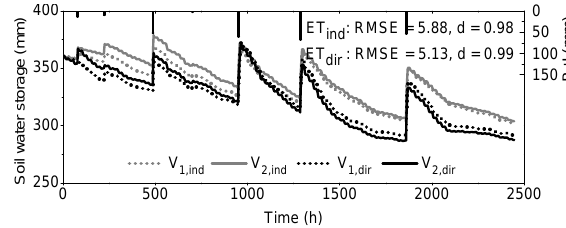
Figure 4. Comparison between simulated root-zone water storage using different methods (i.e., V 1 , ind , V 2 , ind , V 1 , dir , V 2 , dir ) , with measured precipitation and irrigation. The gray dotted line repre- sents water storage calculated with the integration of soil water content over the root-zone and the gray solid line represents water storage calculated with the inversion of the water balance equation within the root zone, using the ET ind method, i.e., V 1 , ind , V 2 , ind , respectively. The black dotted and solid lines represent the ET dir method.